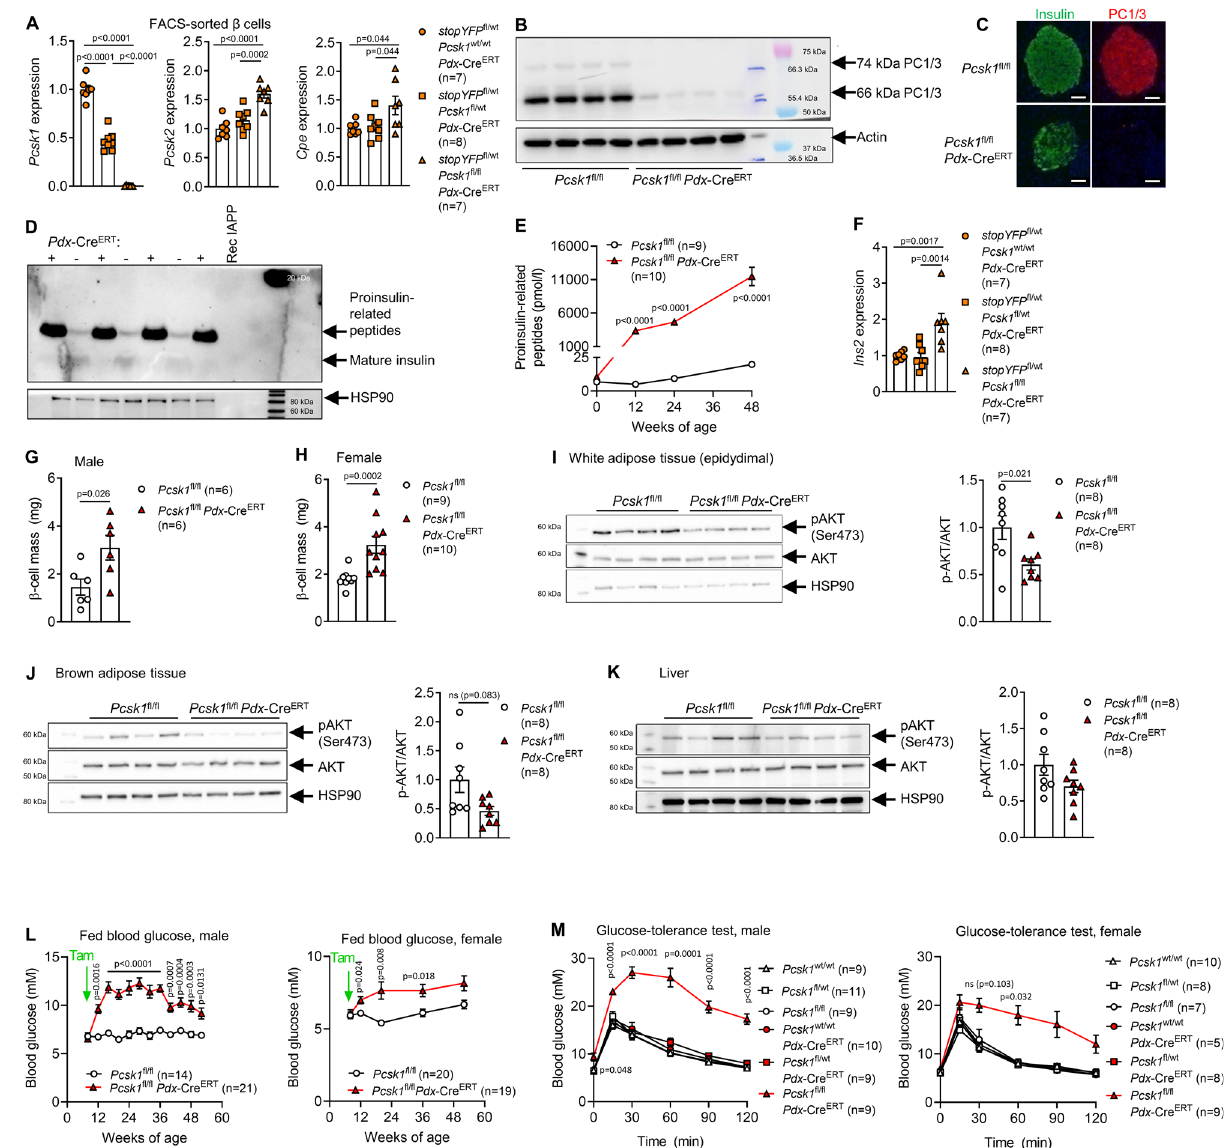
Fig. 3 | β cell-speci fi c Pcsk1 ablation blocks proinsulin processing and induces hyperglycemia but not overt diabetes. A RNA analysis of FACS-sorted β cells (YFP+) dispersed from islet isolated from 12-week-old mice 4 weeks after induction. B PC1/3 western blot of isolated islets 15 weeks after induction. C Insulin and PC1/3-stained pancreatic section. Scale bar, 50 μ m. D Insulin wes- tern blot of whole islets isolated from 12-week-old mice 4 weeks after induction. E Circulatinglevelsofproinsulin-relatedpeptidesinmalemice. F RNAanalysisof FACS-sorted beta cells (YFP+) dispersed from islet isolated from 12-week-old mice4weeksafterinduction. G , H β -cellmassin20-week-oldmice12weeksafter induction. I – K AKT western blot in white adipose tissue, brown adipose tissue, and liver after injection of 2gkg − 1 glucose following an overnight fast in male